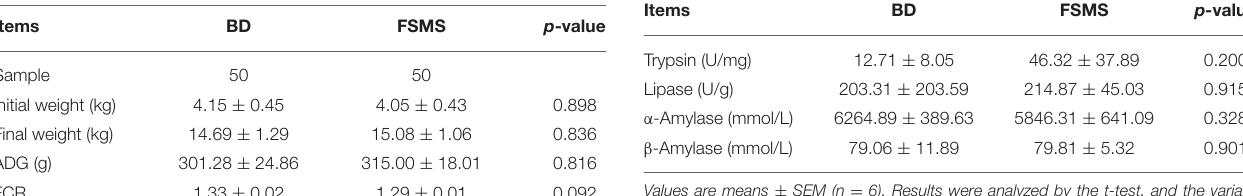
TABLE 2 | Influence of FSMS addition on porcine growth performance indexes.